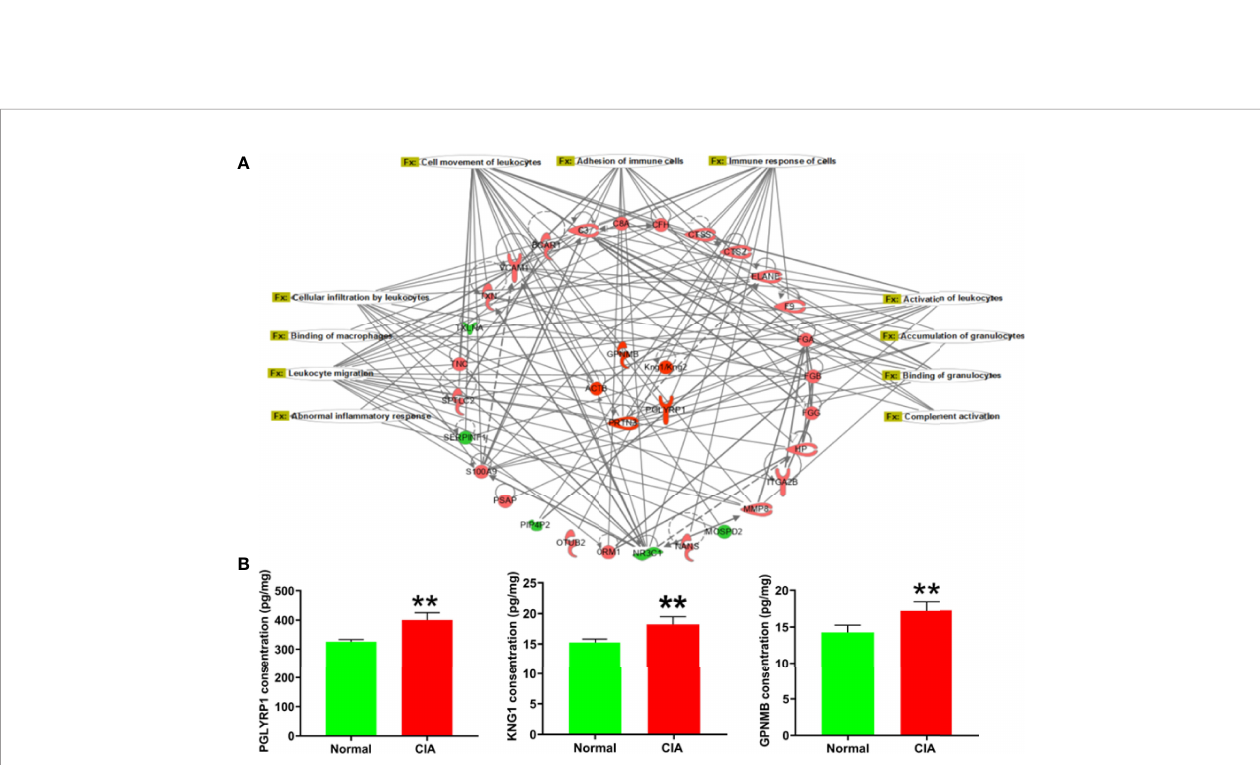
FIGURE 5 | The levels of FAs in the liver of CIA rats in the induction phase. Data were expressed as mean ± SD. N = 6. * p < 0.05, ** p < 0.01 compared with the normal